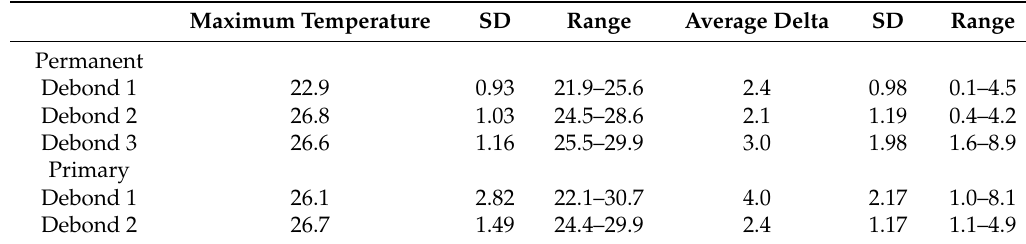
Table 4. Summary of crown temperature during debonding.